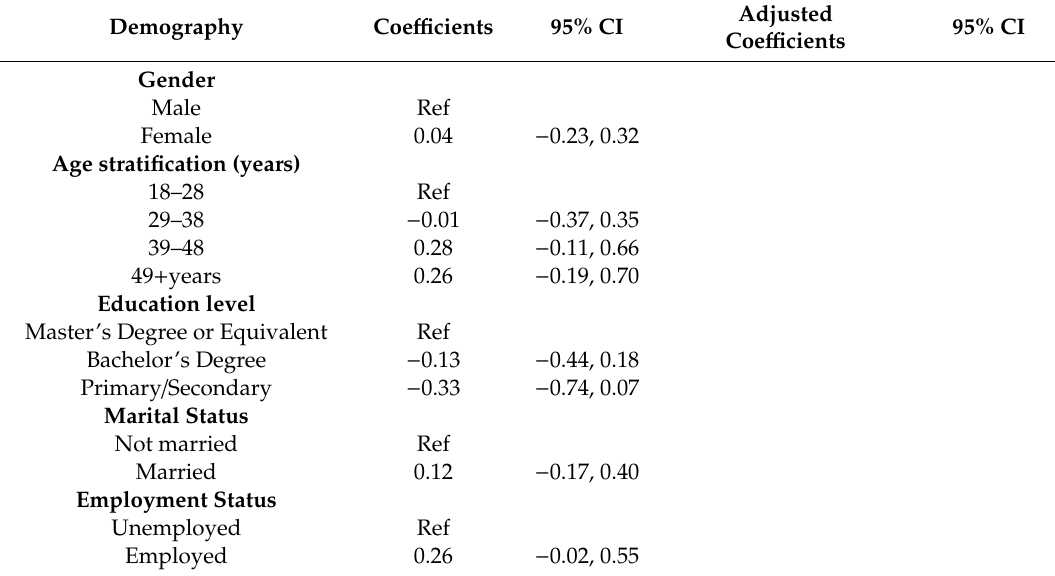
Table A4. Coe ffi cients for factors associated with the knowledge of COVID-19 among the respondents in Bangladesh during the late lockdown period. Confidence intervals CI including zero are not significant